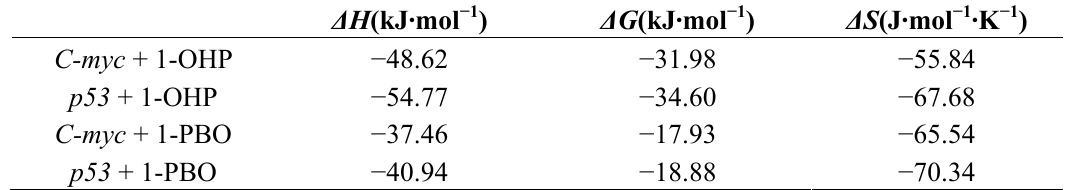
Table 2. Thermodynamic constants of the interaction of pyrene derivatives with